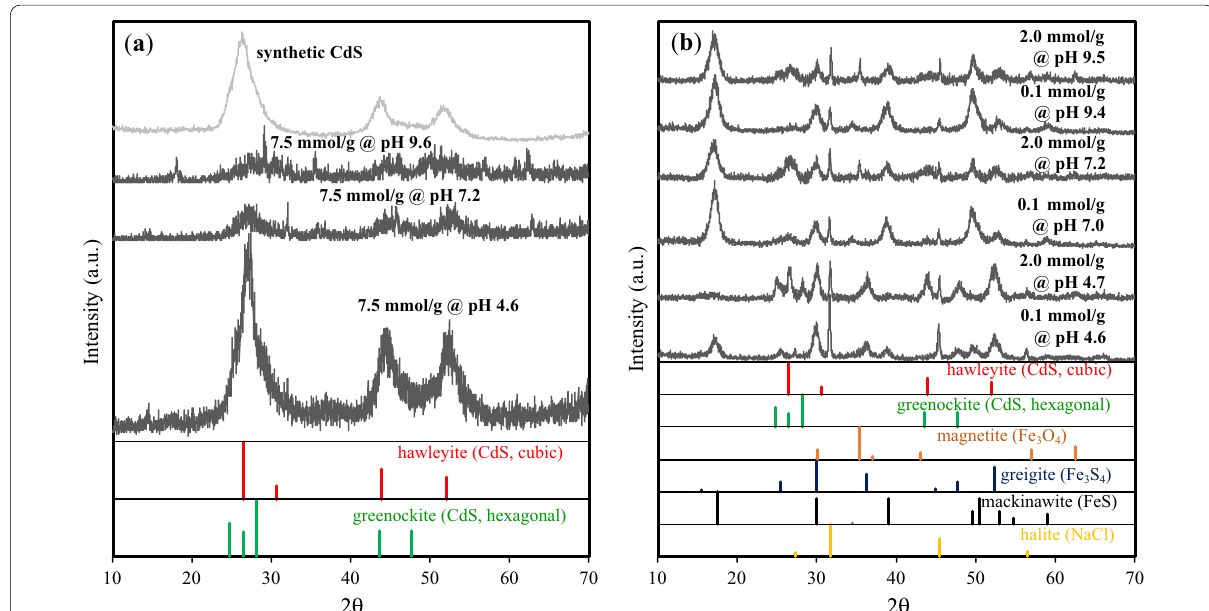
Fig. 3 X‑ray diffraction (XRD) patterns of Cd(II)‑added FeS batches at a high surface loading ( a ) and low surface loadings ( b ). The surface loadings ([Cd(II)] 0 /[FeS] 0 ) and pH are indicated in the